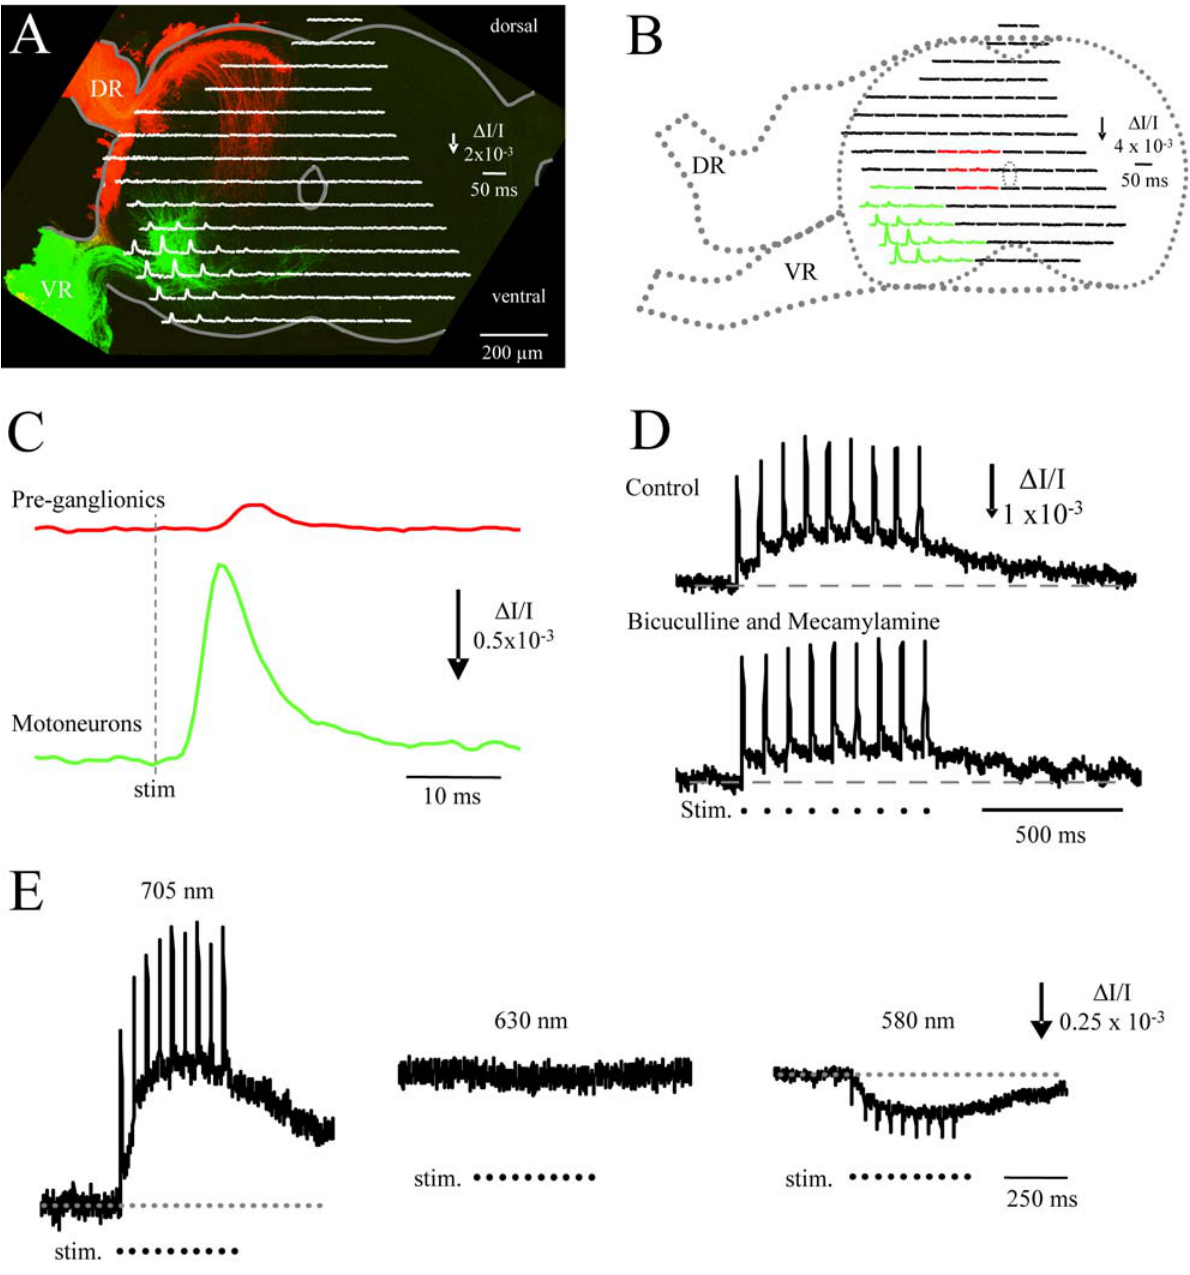
Figure 2. Antidromic stimulation of the ventral roots to identify the location of the motor nucleus. A. The optical responses recorded from the photodiode array are shown superimposed over a confocal transverse section of the slice in which the recordings were made. After the optical experiment, the slice was fixed and motoneurons werelabeled retrogradely withDiI (green) applied to the ventral root and primary afferents werelabeled anterogradely with DiO (red) applied to the dorsal root. Each optical signal is the response to a single antidromic stimulus averaged from a train of stimuli (8 stimuli at 20 Hz) and recorded in the presence of a cholinergic (mecamylamine 50 m M) and a GABAA (bicuculline 50 m M) antagonist to block the synaptic inputs from R-interneurons onto motoneurons (33). The largest antidromic responses coincided with the location of motoneuron cell bodies. B. Antidromically-evoked optical responses from another cord in which it was possible to detect antidromic spikes adjacent to the central canal at a location corresponding to that of preganglionic neurons (red traces), in addition to those over the motor nucleus (green traces). DR-dorsal root; VR-Ventral Root. The colored traces in panel B have been averaged and are displayed on an expanded scale in C. It can be seen that the antidromic responses near the central canal are smaller and have a longer latency that those recorded from the motor nucleus. D. The slow antidromic responses recorded over motoneurons are depressed in the presence of the nicotinic cholinergic antagonist mecamylamine and the GABAA receptor antagonist bicuculline to block the recurrent synaptic input from R-interneurons to motoneurons. The upper trace (control) was obtained under control conditions and the lower trace (bicuculline and mecamylamine) in the presence of the drugs. The time of the ventral root stimuli (stim.) are marked by the dots beneath the traces. E. Spectrum of optical responses recorded over motoneurons and evoked by ventral root stimulation under control conditions. The signals were obtained at three different illumination wavelengths in response to a train of ventral root stimuli (stim.). Note the reversal of the signals at 580 nm and the absence of a significant signalat630 nm, the isosbestic point of the dye. Thetimes of the ventralroot stimuli (stim.) are indicated beneath the traces. In this, and all other figures, the vertical calibration arrows indicate the direction of increased light transmission (decreased light absorption). Data in A from an E11 embryo and in B, C and D from an E10 embryo. Data in E from an E11